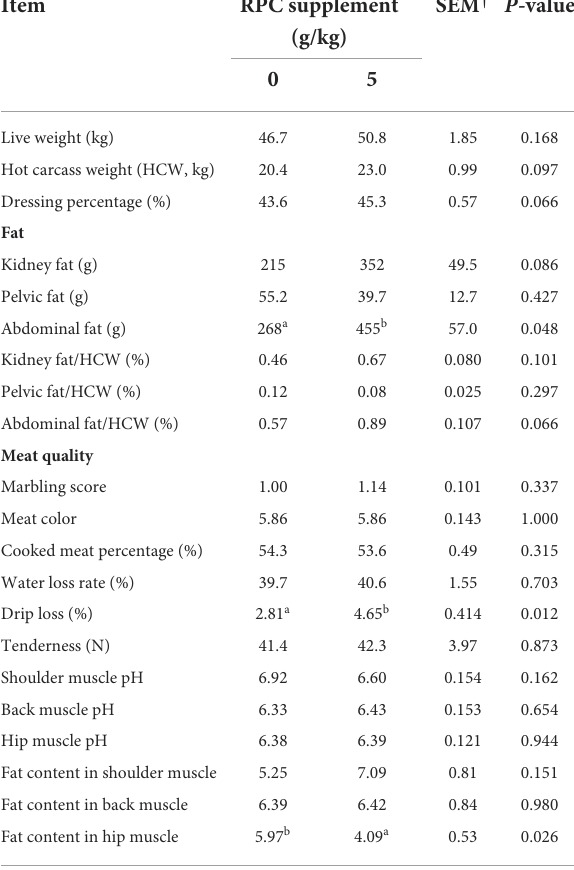
TABLE 6 Slaughter performance and meat quality of fattening lambs fed experimental diets supplemented with nil or rumen-protected choline (RPC) ( n = 7 per